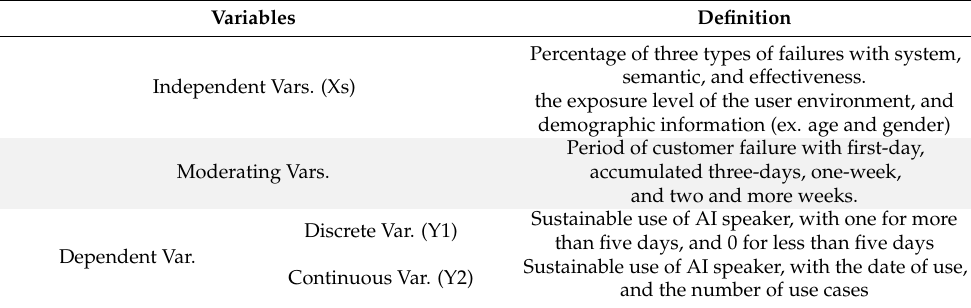
Table 3. Operational definition of